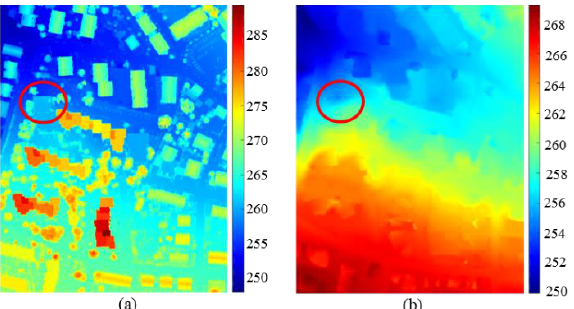
Figure 6. Area1 DSM derived from LiDAR data (a) and the reference DTM.